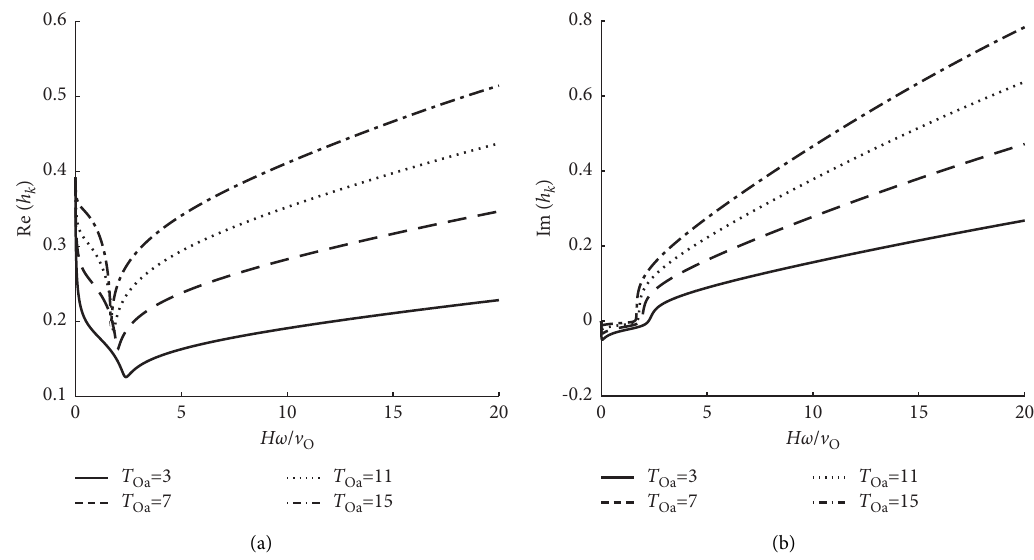
Oa ). (a) Horizontal stiffness factor of the soil layer.